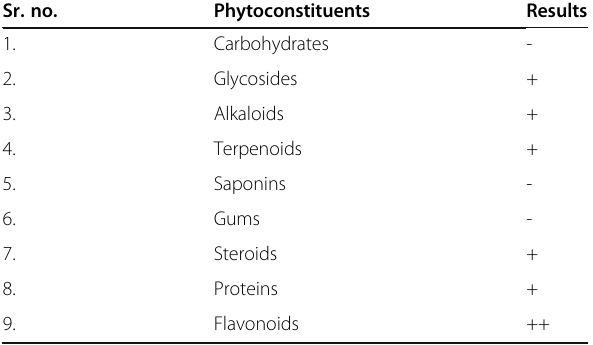
Table 1 Preliminary phytochemical investigation of EEC Sr. no.